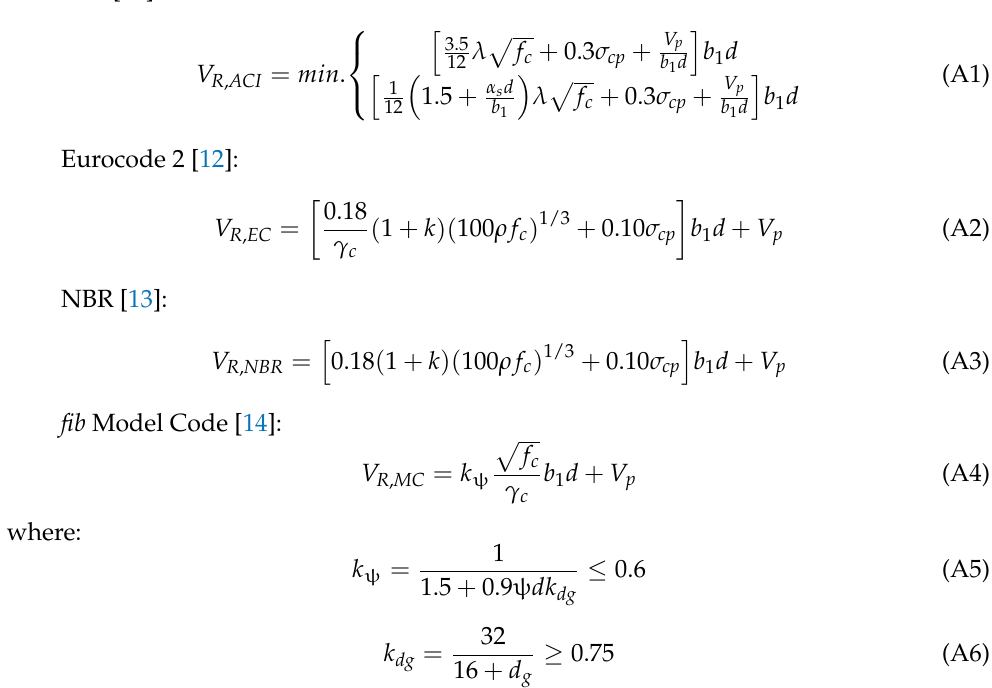
according to the following equations for dimensioning prestressed flat slabs.